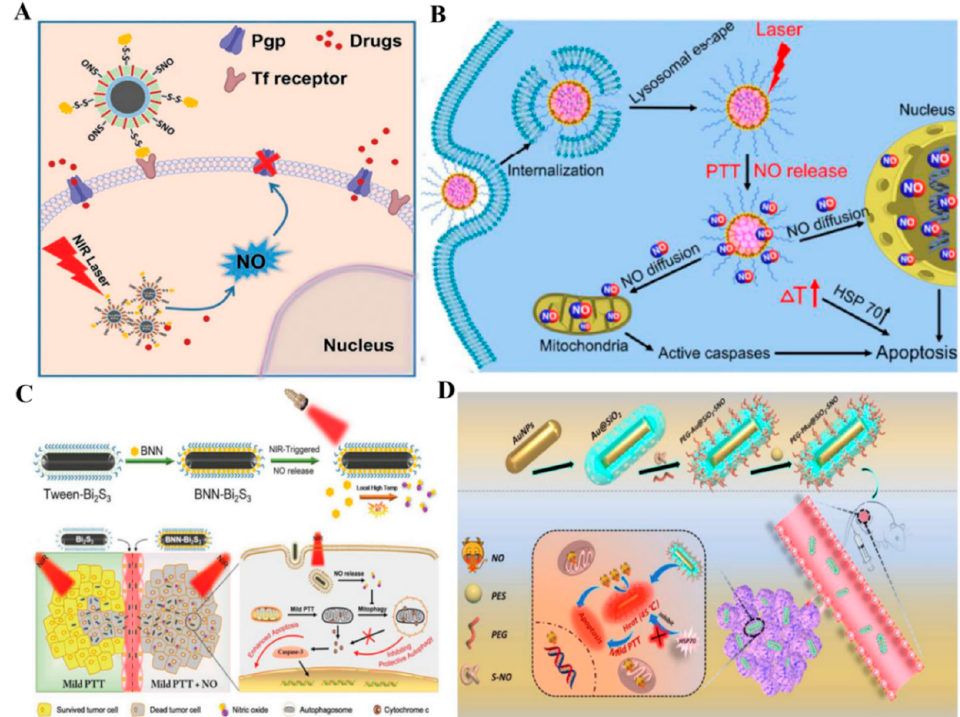
Figure 2. ( A ) Schematic diagram of the preparation and release of NO from photo-triggered NO nanogenerators (PTNG). Reproduced with permission from [71], Advanced Functional Materials, 2017; ( B ) schematic diagram representation of the therapeutic function of PpRE@PEG–PpIX NPs. Reproduced with permission from [72], Nano Research, 2019; ( C ) sche- matic diagram of the synthesis and NIR light-triggered NO release from the BNN–Bi 2 S 3. Reproduced with permission from [74], Advanced Science, 2019; ( D ) schematic diagram of the preparation of PEG–PAu@SiO 2 –SNO and the process of mild heat-enhanced NO therapy under NIR irradiation in cancer cells. Reproduced with permission from [76], ACS